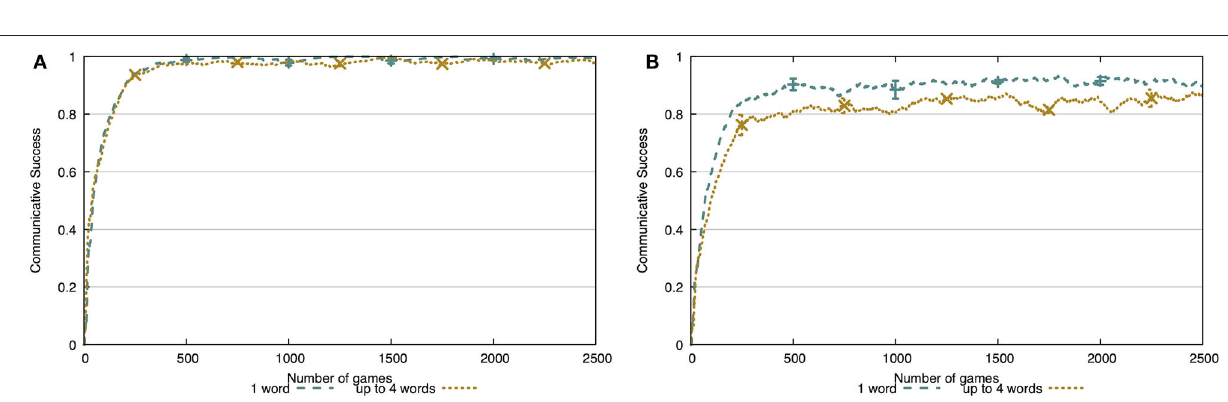
FIGURE 14 | Comparison of the communicative success when the tutor uses one or up to four words. In both the simulated environment (A) and the extracted environment (B) , there is a drop in communicative success (3 and 8 p.p., respectively).